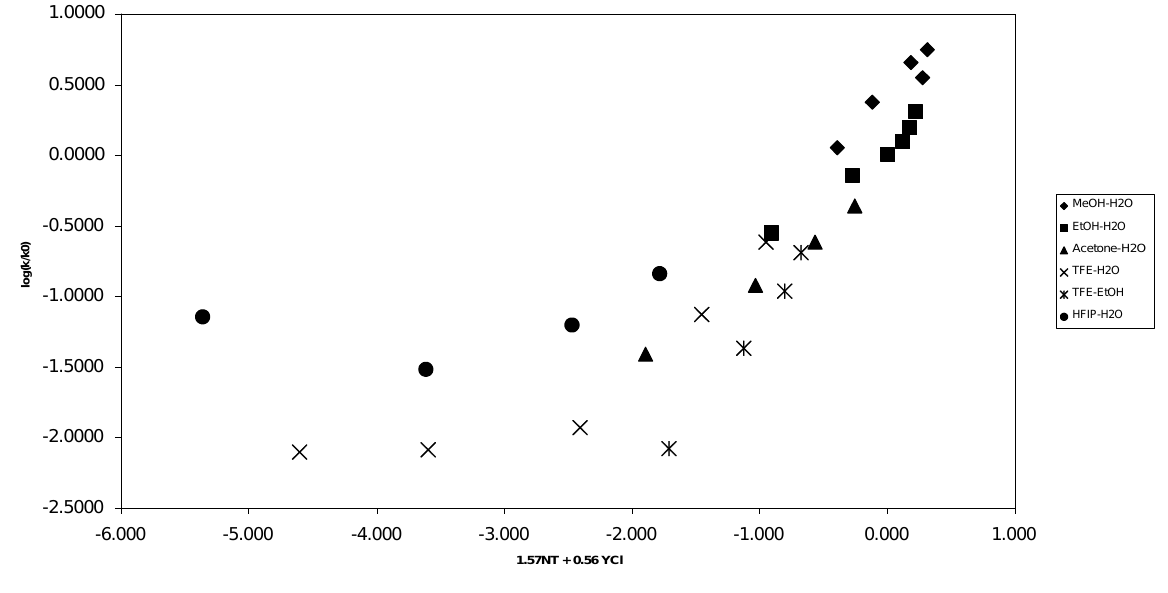
Figure 1. The plot of log ( k / k ) vs. (1.57 N + 0.56 Y ) for the solvolysis of n -propyl 0 T Cl chloroformate in pure and binary solvents at 25.0 ºC. The data points for 100% O mixtures were not included in the correlation; TFE, 97% TFE, and all HFIP–H 2 they are added to the plot to show their considerable deviation from the correlation line. Correlation coefficient (r) is